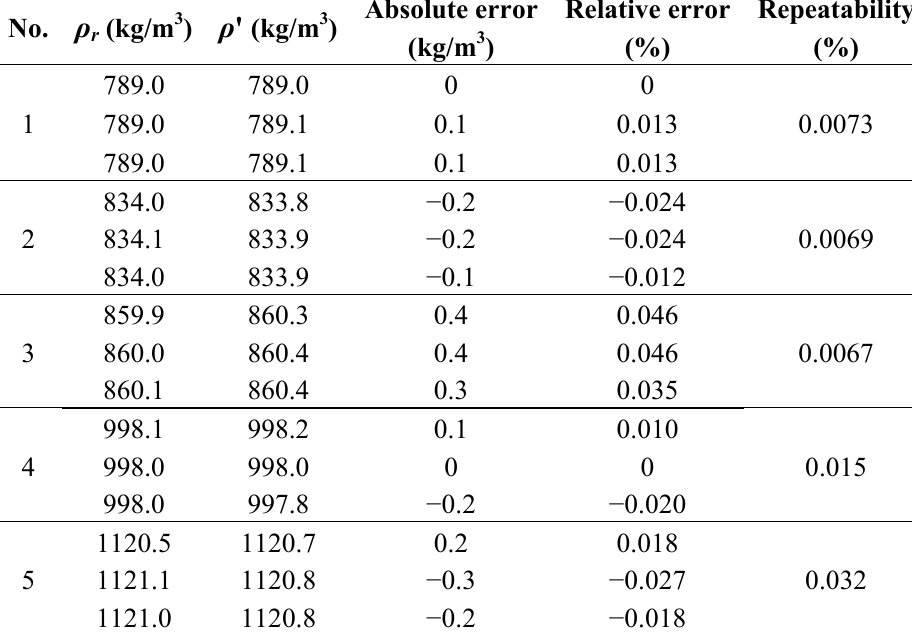
Table 2. Experimental data at 20